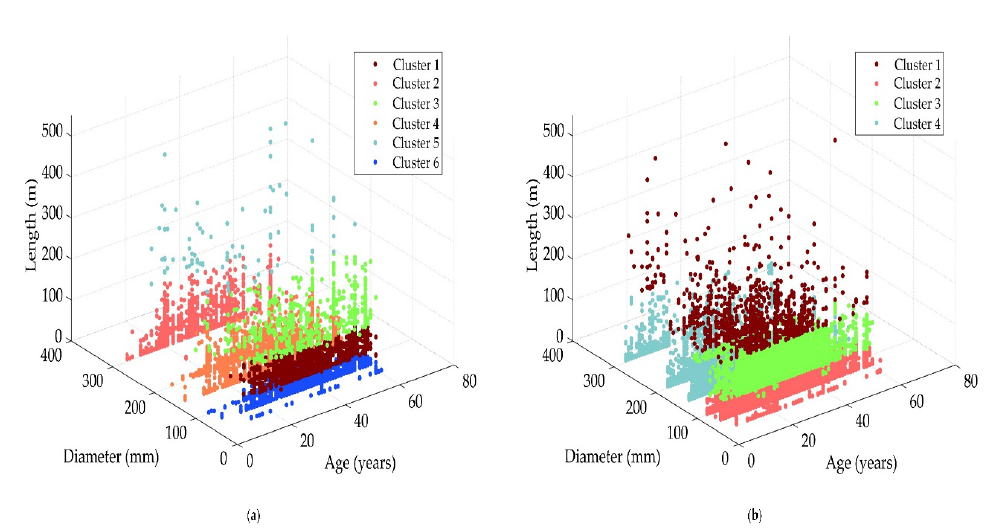
Figure 4. Data clustering: ( a ) Asbestos-cement pipes and ( b ) polyvinyl chloride (PVC) pipes.